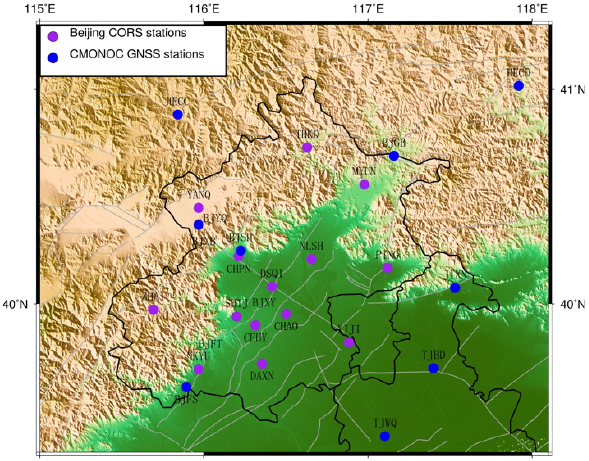
Figure 2. Distribution map of the GNSS stations used in this study.